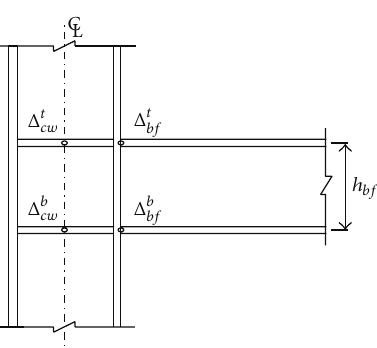
Figure 20: The temperature graph: the rotation with the bolted cover plate.